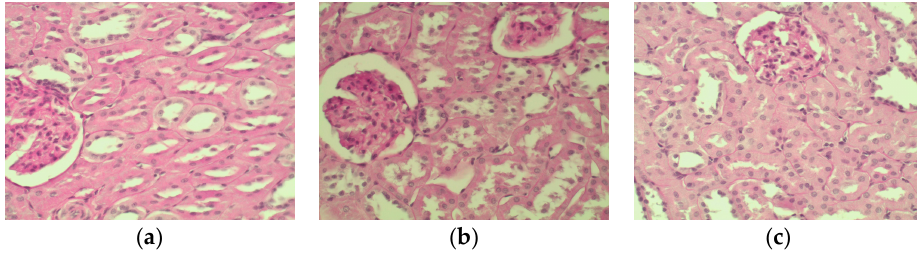
Figure 10. ( a ) Kidney of a control rat (proximal convoluted tubules with an intact brush border); ( b ) Kidney of a rat exposed to the ternary MeO-NP combination (marked degenerative and necrobiotic ( b ) Kidney of a rat exposed to the ternary MeO-NP combination (marked degenerative and necrobiotic changes in tubular epithelial cells up to their disappearance; partial destruction of the brush border); changes in tubular epithelial cells up to their disappearance; partial destruction of the brush border); ( c ) Kidney of a rat exposed to the same combination against background administration of the BPC. ( c ) Kidney of a rat exposed to the same combination against background administration of the BPC. Periodic Acid Shiff (PAS) stain, magnification 400×. Periodic Acid Shiff (PAS) stain, magnification 400 ×